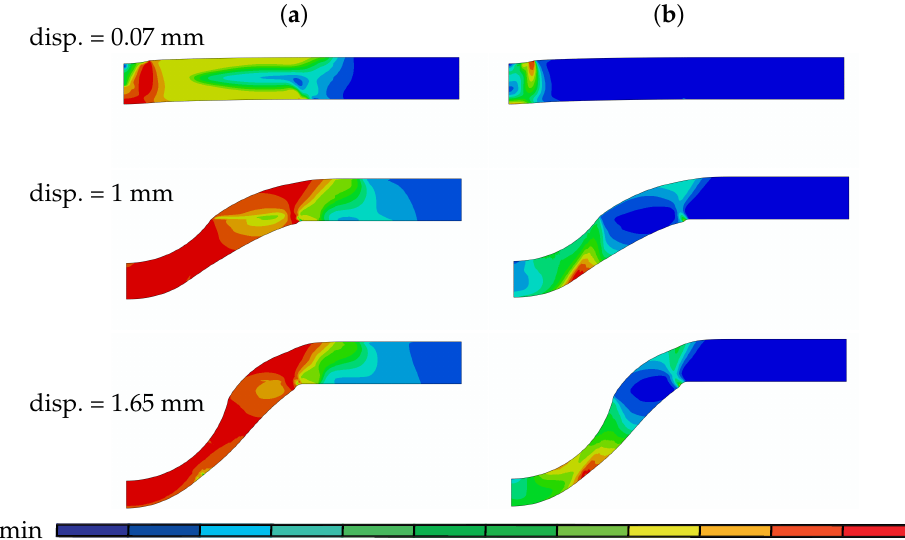
Figure 4. ( a ) von Mises stress and ( b ) plastic strain plots of SP disk with 0.5 mm thickness at various displacements: 0.77 mm ( a ) [max 7.69 × 10 2 ; min 0], ( b ) [max 1.24 × 10 − 1 ; min 0], 1